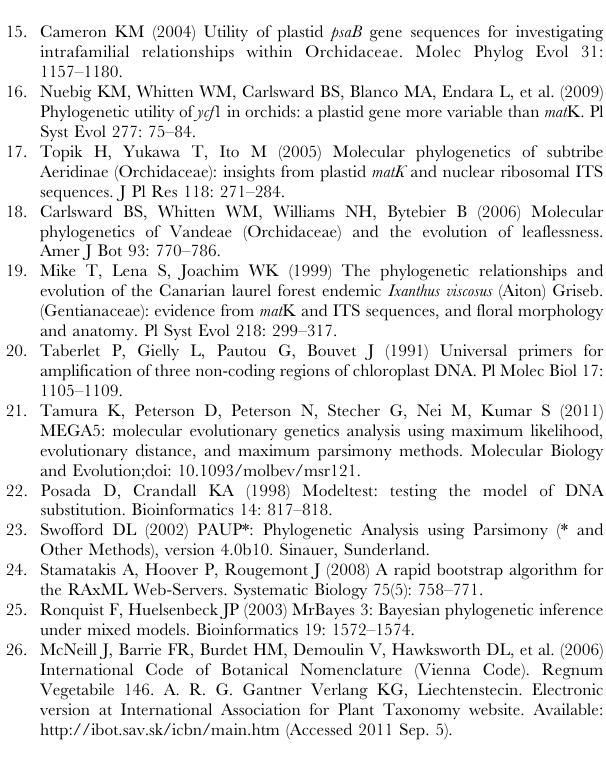
Table S1 Pair-wise genetic distance of all species based on combined datasets of ITS, trnL-F , and matK . Table S2 Samples used in the gene sequencing and their information. Table S3 Genetic distances between sections of the Holcoglossum clade. Table S4 Morphological data matrix for the phylogenetic